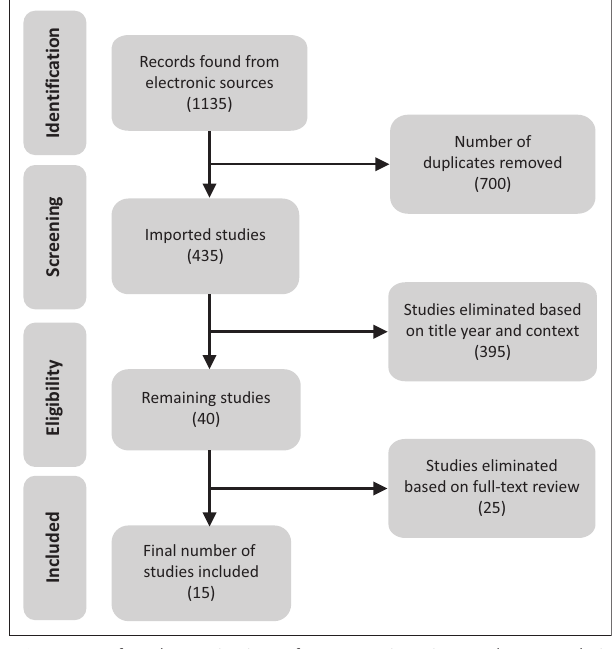
FIGURE 1: Preferred reporting items for systematic reviews and meta-analysis model employed in the study, modified after Boell and Cecez-Kecmanovic.